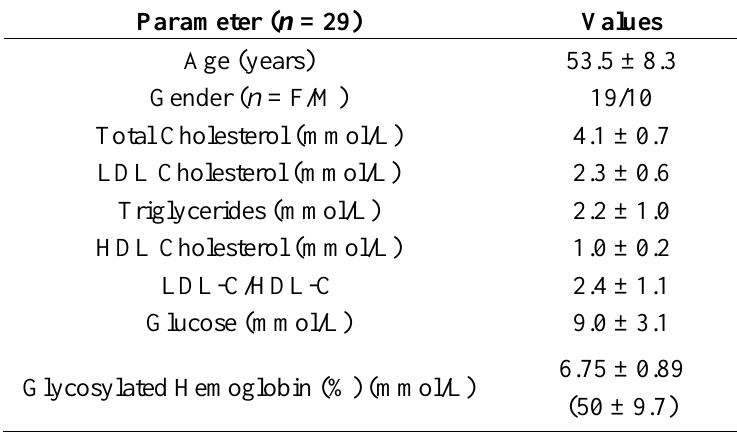
Table 1. Baseline Characteristics of Subjects